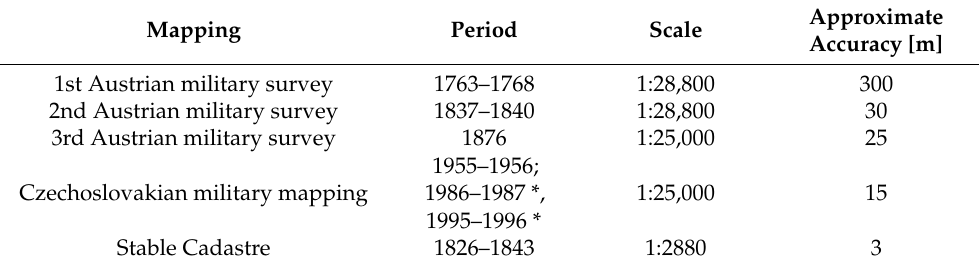
Table 2. A summary of the cartographic sources applied in the identification procedures. Mapping Period Scale